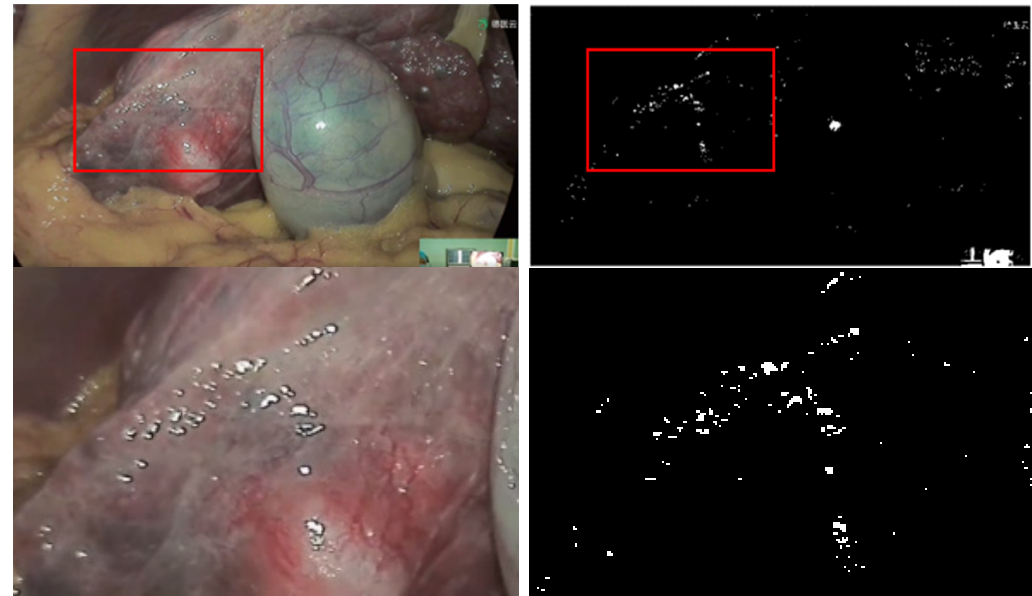
Figure 6. Highlight mask and corresponding original images.